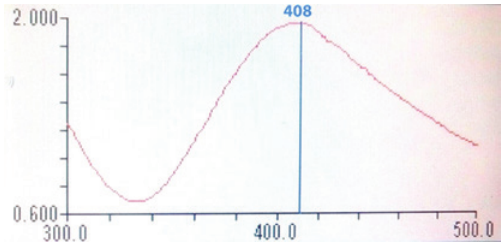
Figure 5: Surface plasmon resonance spectrum of the synthesized AgNPs at obtained optimum synthesis conditions.